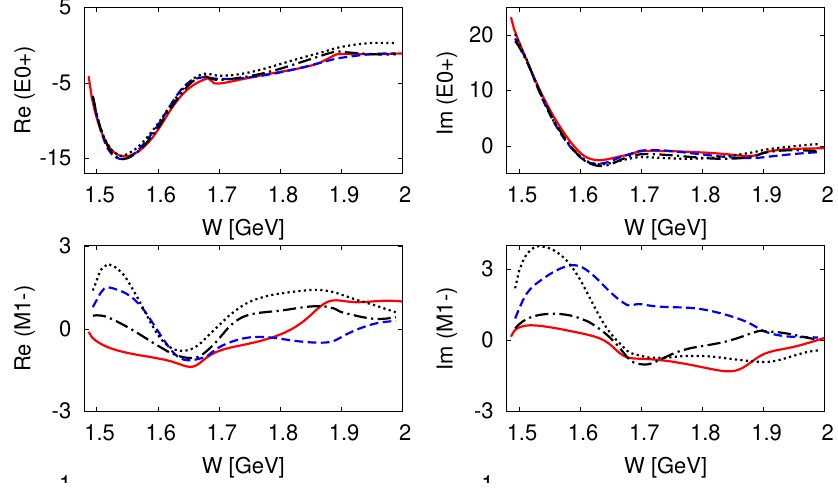
Figure 2. Comparison of E 0 + ( S 11 ) and M 1 − ( P 11 ) multipoles for γ p → η p , obtained from rotated helicity amplitudes (see Eq. (6)) of di ff erent PWA. The solid red lines show our EtaMAID2018 solution. Results of other PWA analyses are shown by the black dash-dotted (BnGa [18]), the black dotted (JüBo [19]), and the blue dashed (KSU [20]) lines. The multipoles are given in units of